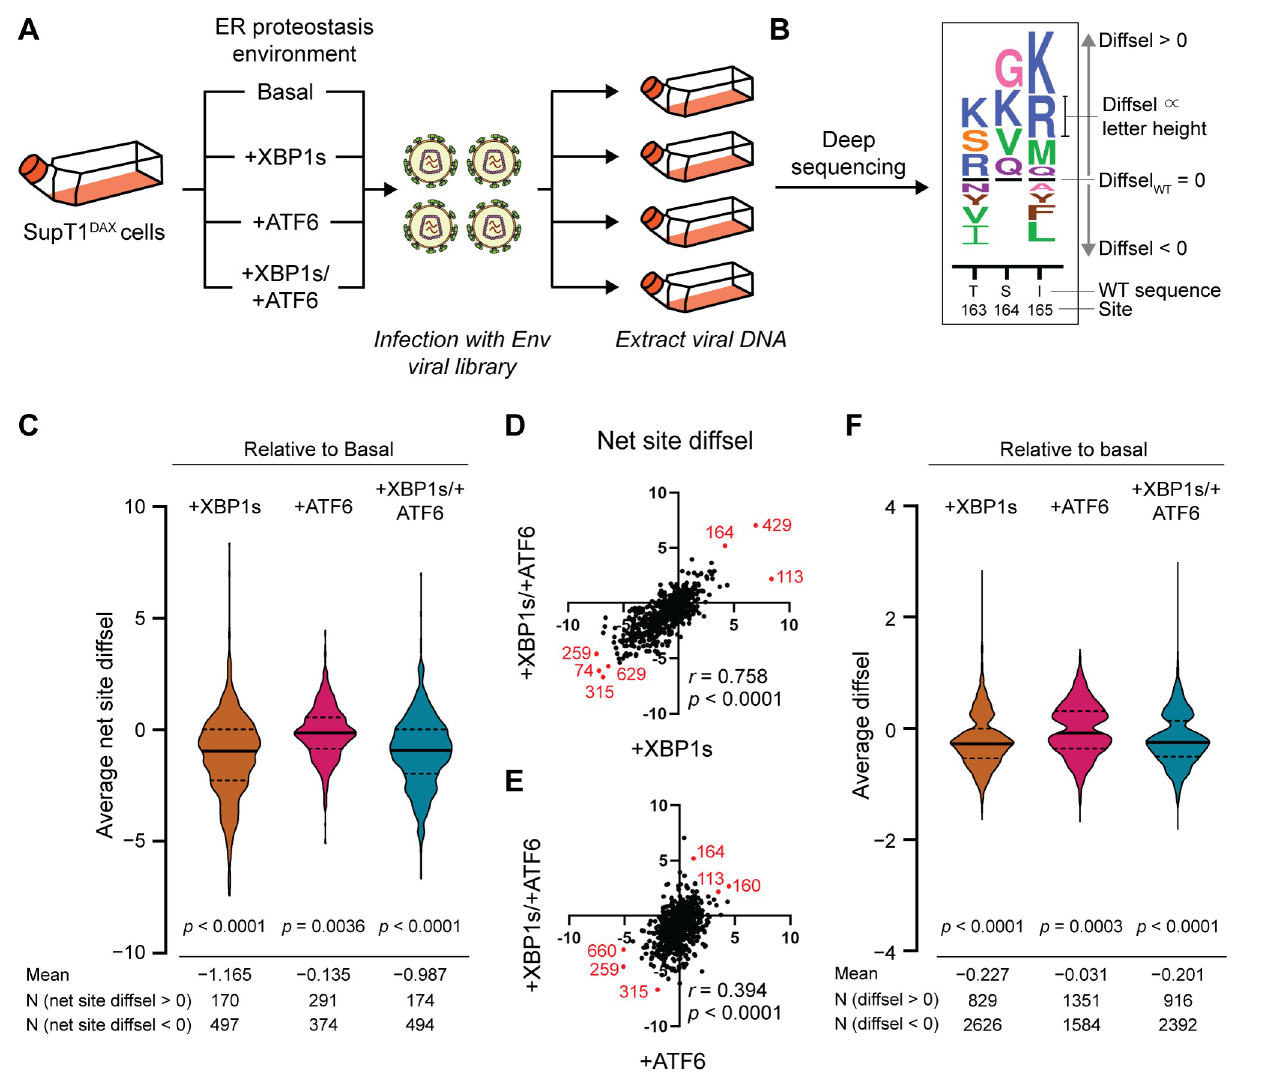
Fig 2. Upregulation of the host cell’s ER proteostasis environment generally reduces mutational tolerance across the Env protein sequence. (A) Scheme for deep mutational scanning of Env in 4 distinct ER proteostasis environments (basal, +XBP1s, +ATF6, and +XBP1s/+ATF6). SupT1 DAX cells were pretreated with DMSO (basal), dox (+XBP1s), TMP (+ATF6), or both dox and TMP (+XBP1s/+ATF6) 18 h prior to infection with biological triplicate Env viral libraries. 4 d post-infection, cells were harvested, and non-integrated viral DNA was sequenced to quantify the diffsel of Env variants. (B) Diffsel for each amino acid variant can be visualized in a sequence logo plot. The black horizontal lines at the center represent the diffsel for the wild-type amino acid at that site, and the height of the amino acid letter abbreviations is proportional to the diffsel of that variant in the remodeled ER proteostasis environment relative to the basal environment. Variants that are relatively enriched in the indicated ER proteostasis environment (positive diffsel) are located above the black horizontal line. Variants that are relatively depleted in the indicated ER proteostasis environment (negative diffsel) are located below the black horizontal line. (C) Net site diffsel for all Env sites in 3 perturbed ER proteostasis environments, averaged over biological triplicates. The black horizontal lines on the violin plots indicate the median (solid line) and the first and the third quartiles (dashed lines) of the distribution. The significance of deviation from null (net site diffsel = 0, no selection) was tested using a 1-sample t test, with 2-tailed p -values shown. The mean of the distribution and the number of sites with net site diffsel > 0 or < 0 are listed below the distribution. (D and E) Correlation for net site diffsel values for (D) +XBP1s/+ATF6 versus +XBP1s and (E) +XBP1s/+ATF6 versus +ATF6, normalized to the basal proteostasis environment. Pearson correlation coefficients ( r ) and corresponding p -values are shown. Select sites with highly positive or highly negative net site diffsel values in both proteostasis environments are marked in red and labeled with site numbers. (F) Diffsel for individual Env variants in 3 perturbed ER proteostasis environments, averaged over biological triplicates. The black horizontal lines on the violin plots indicate the median (solid line) and the first and the third quartiles (dashed lines) of the distribution. The significance of deviation from null (diffsel = 0, no selection) was tested using a 1-sample t test, with 2-tailed p -values shown. The mean of the distribution and the number of sites with diffsel > 0 and < 0 are listed below the distribution. Diffsel values (C–F) are provided at https://github.com/yoon-jimin/2021_HIV_Env_DMS. diffsel, differential selection; dox, doxycycline; ER, endoplasmic reticulum; TMP, trimethoprim; WT, wild-type.